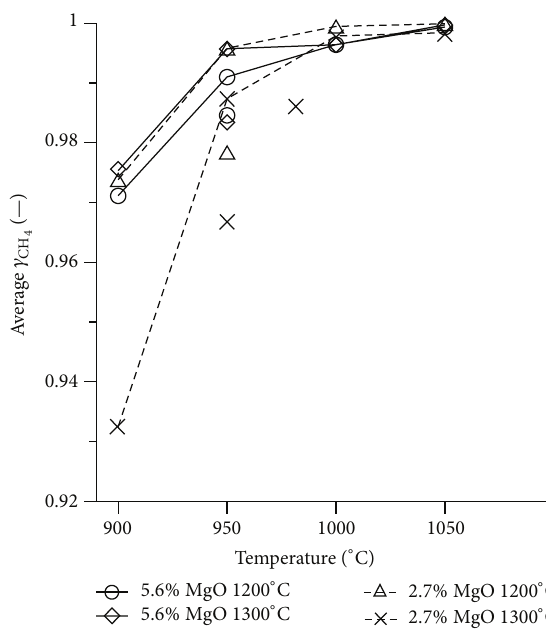
Figure 10: The average methane yield of 5.6% MgO and 2.7% MgO oxygen carriers as a function of temperature (data was selected for 𝜔 from 1 to 0.99). The single dots separated from the lines present the results at 950 ∘ C (2)